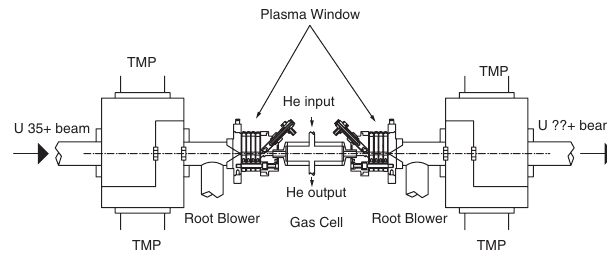
FIG. 9. Conceptual illustration of low- Z gas stripper for U 35 þ beam with a pair of plasma windows (PWs). A gas cell with He input/output is located between the PWs. A pair of a root blower and two TMPs are located to connect the PWs with background vacuum for uranium beam.